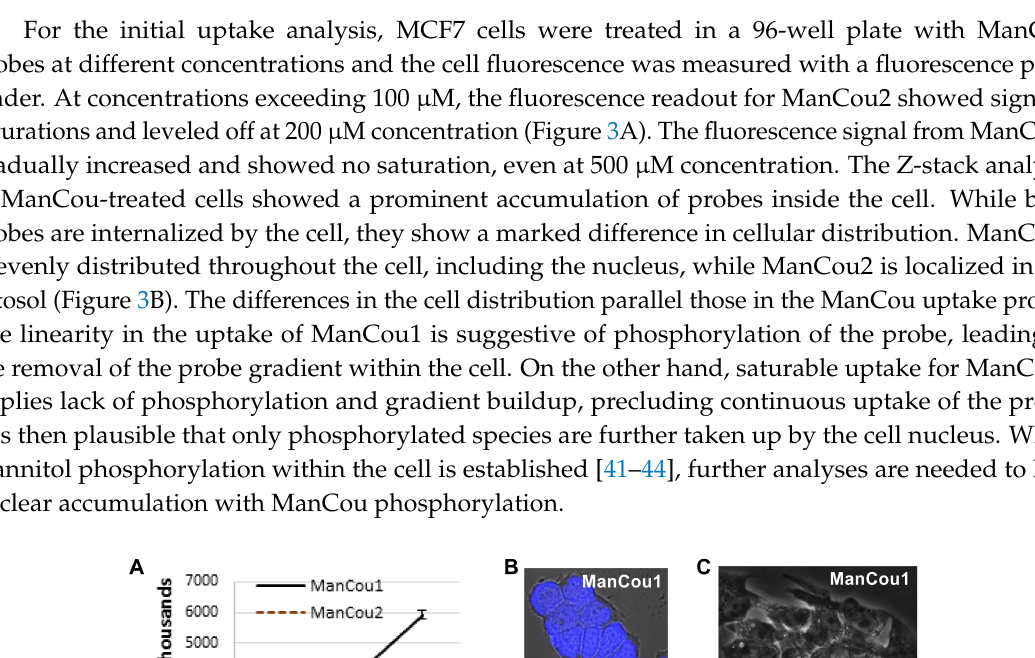
Figure 2. Synthesis of ManCou analogs.